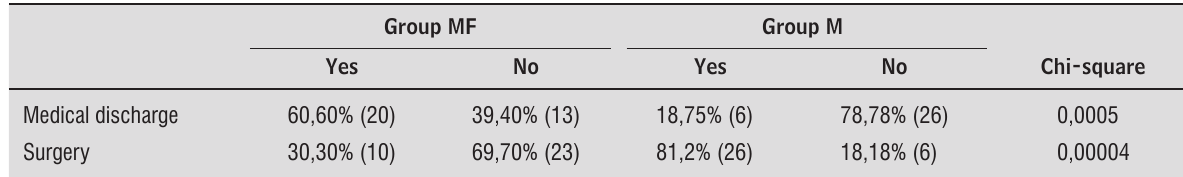
Table 4 - Frequency of medical discharge and surgery in both